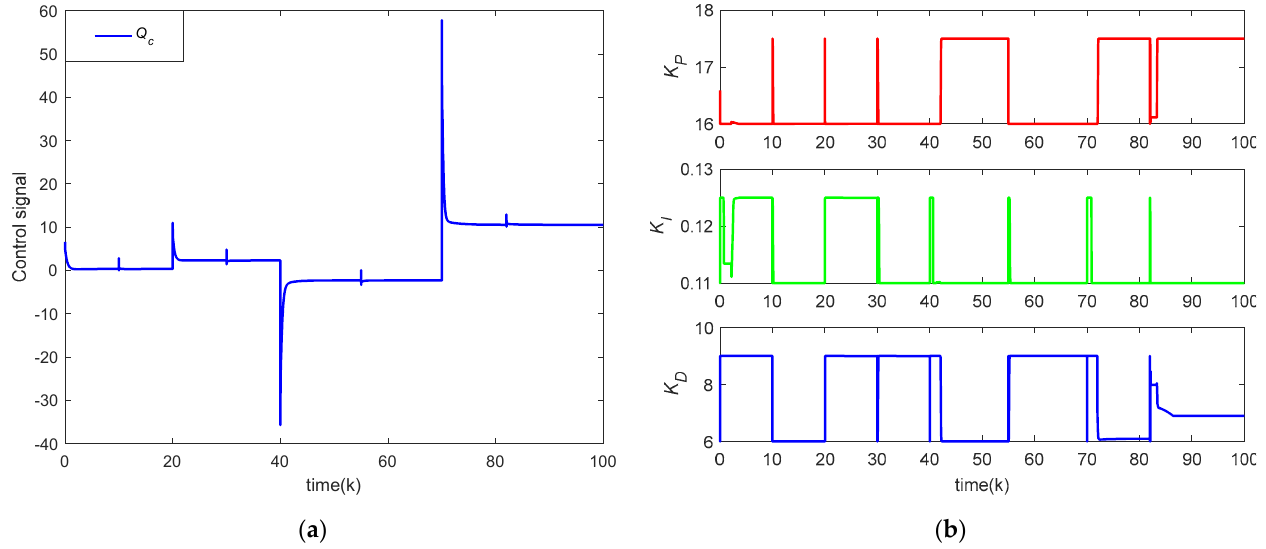
Figure 10. Changes of the control signal and controller parameters in single-point perturbation situations. ( a ) Changes of the commanded motor torque Q c . ( b ) Changes of K P , K I , and K D .